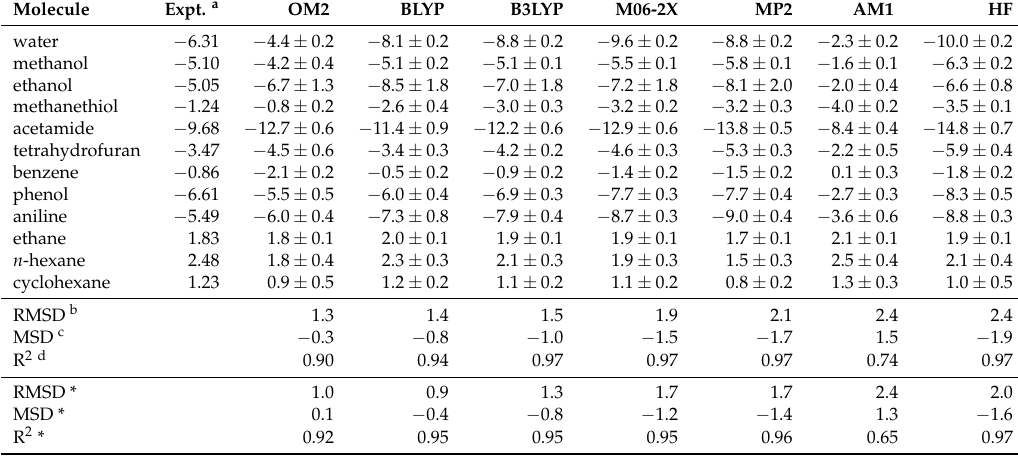
a Experimental hydration free energies. b Root mean squared deviation from experimental data. c Mean signed deviation from experimental data. d Square of the Pearson correlation coefficient between calculated and experimental hydration free energies. * marks results that exclude ethanol and acetamide due to the